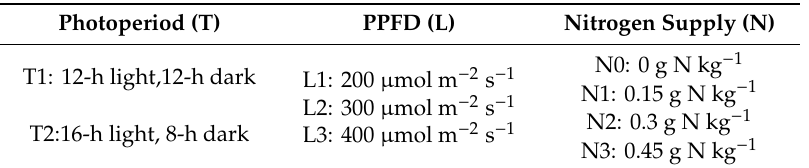
Table 1. Details of the